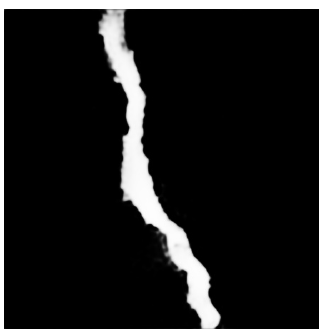
Figure 7. Trend of training and validation loss.